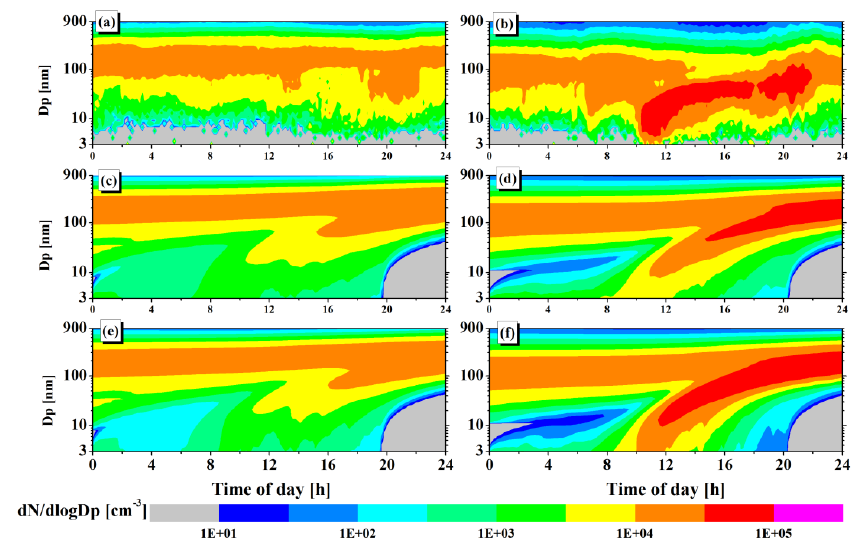
Fig. 2. Measured and modelled particle number size distributions for two selected days. Left panel represents the example of non-event day (6 August, day 219); right panel represents the example of a NPF event day (12 September, day 256); (a, b) measurement, (c, d) modelled with activation nucleation mechanism, (e, f) modelled with kinetic nucleation mechanism.